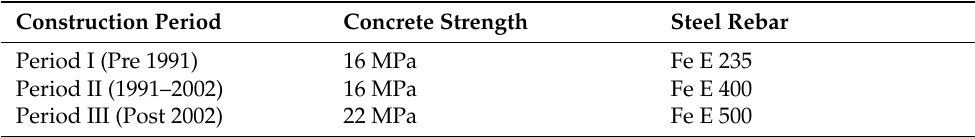
Table 4. Construction material characteristics for defined periods